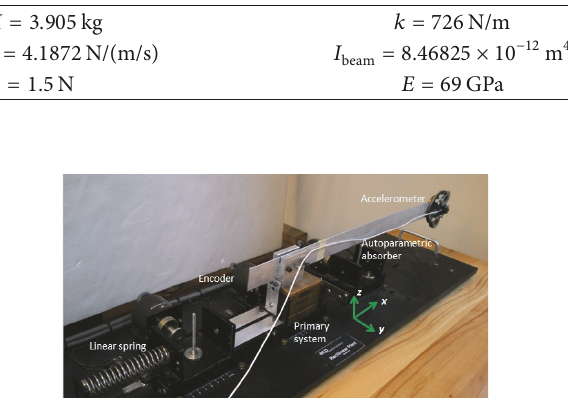
Figure 6: Experimental platform under passive control scheme.